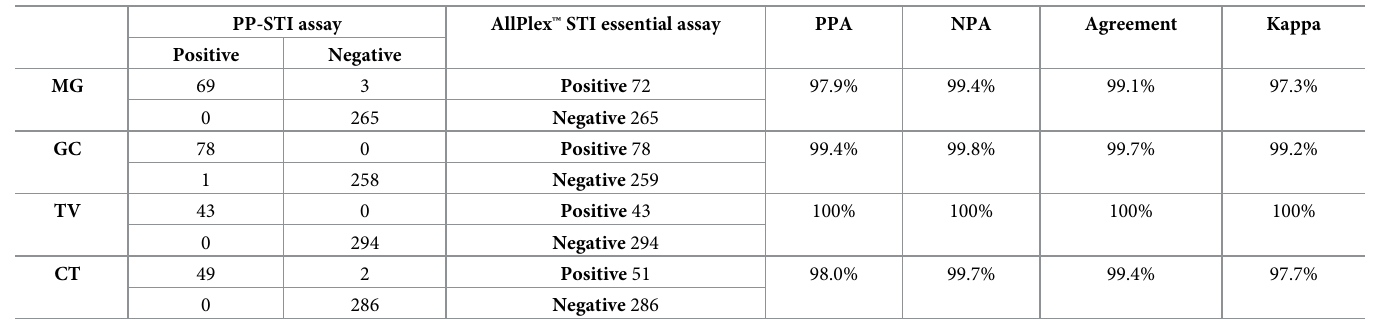
Table 3. Analysis of 337 clinical specimen using the PP-STI assay and the AllPlex ™ STI essential assay. PP-STI